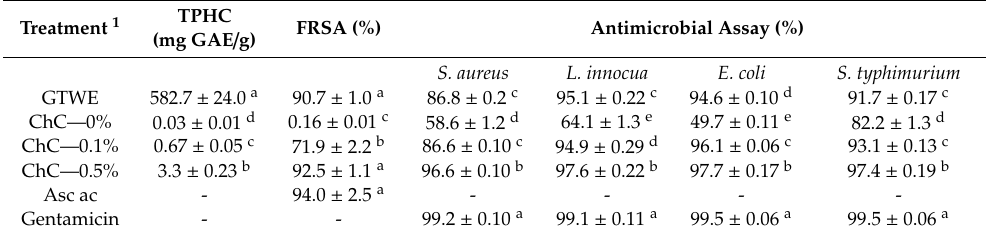
In vitro total phenolic content, antiradical and bacterial inhibition of GTWE and chitosan